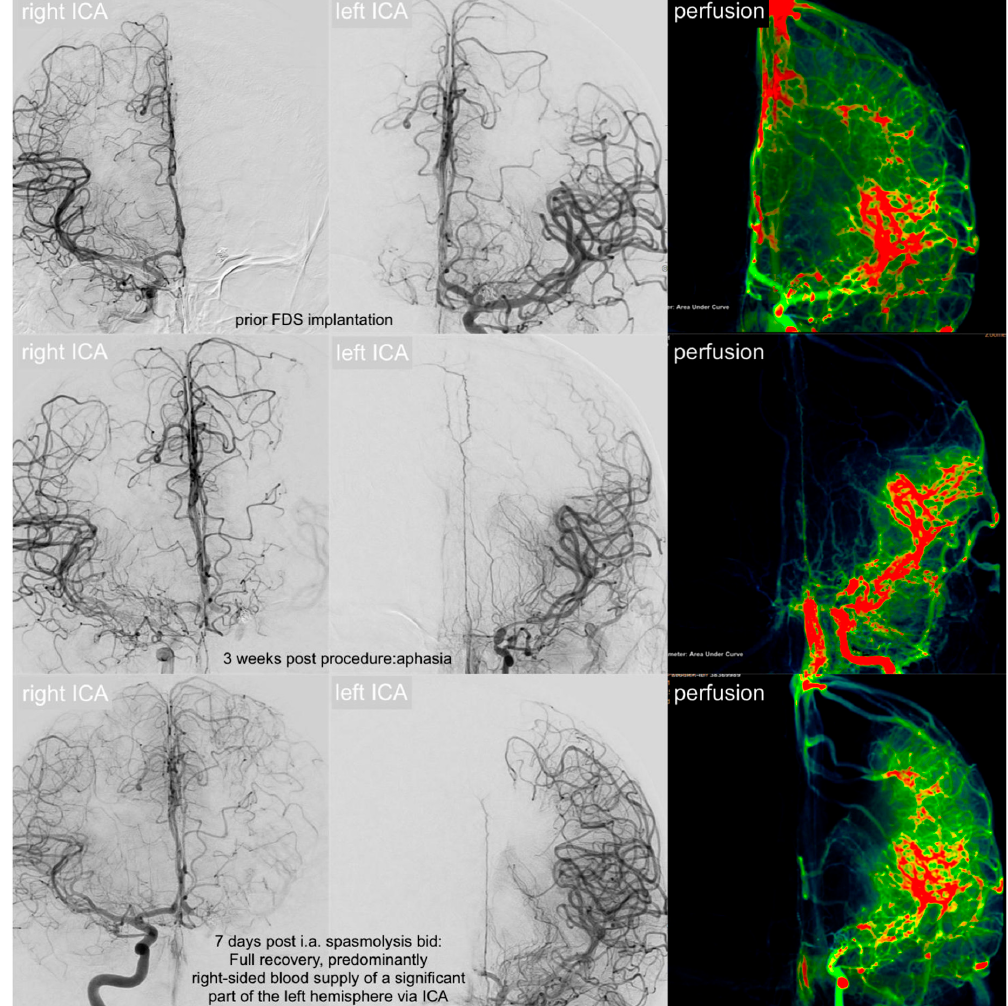
Figure 6. Changes in brain perfusion of the most severe vasospasm case, beginning with the unremarkable status after intervention (upper row), followed by the status when presenting with global aphasia and severe, unilateral headache (middle row, three weeks later), and after a week of mean arterial pressure-driven i.a. anti-vasospastic treatment (inferior row). Upper row—initial status: conventional p.a. angiogram of the right ICA, left ICA, and DSA perfusion prior to FDS implantation: functionally autonomic supply of both hemispheres via each ipsilateral ICA. Middle row—acute-phase vasospasm: significant collateral supply from the right ICA via the AcomA along left A1 for compensation of acute-onset, hemodynamically critical vasospastic stenosis. Note the severely reduced left-sided cerebral blood volume represented by area under the curve perfusion image. Inferior row—equilibrated collateral flow and increase in left-sided brain perfusion after multiple intra-arterial treatments for segmental vasospasm. Eventually, the left and right ACA territory is supplied from the right ICA. Left MCA perfusion is sufficient via the left ICA. Eventually, the extent of subacute vasospasm decreased beginning on day six, allowing for a reduction of intra-arterial treatment on day seven and cessation of invasive biochemical angioplasty on day eight. The patient was closely monitored on the intensive care unit (ICU) for the four